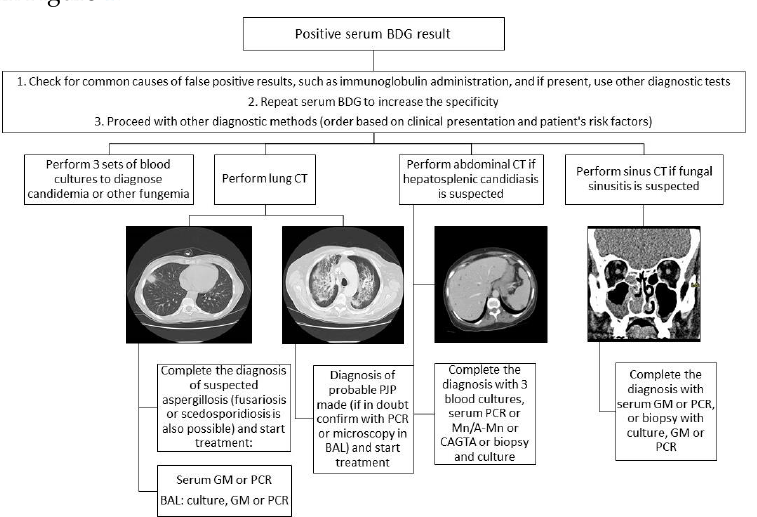
Figure 1. Practical approach to the use of a positive BDG result in patients with HM (BAL, bronchoalveolar lavage; CAGTA, Candida albicans germ-tube antibody IgG assay; CT, computed tomography; Mn/A-Mn, mannan antigen and anti- mannan antibodies; PCR, polymerase chain reaction).